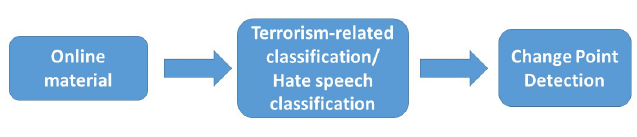
Figure 1. Change point detection framework.